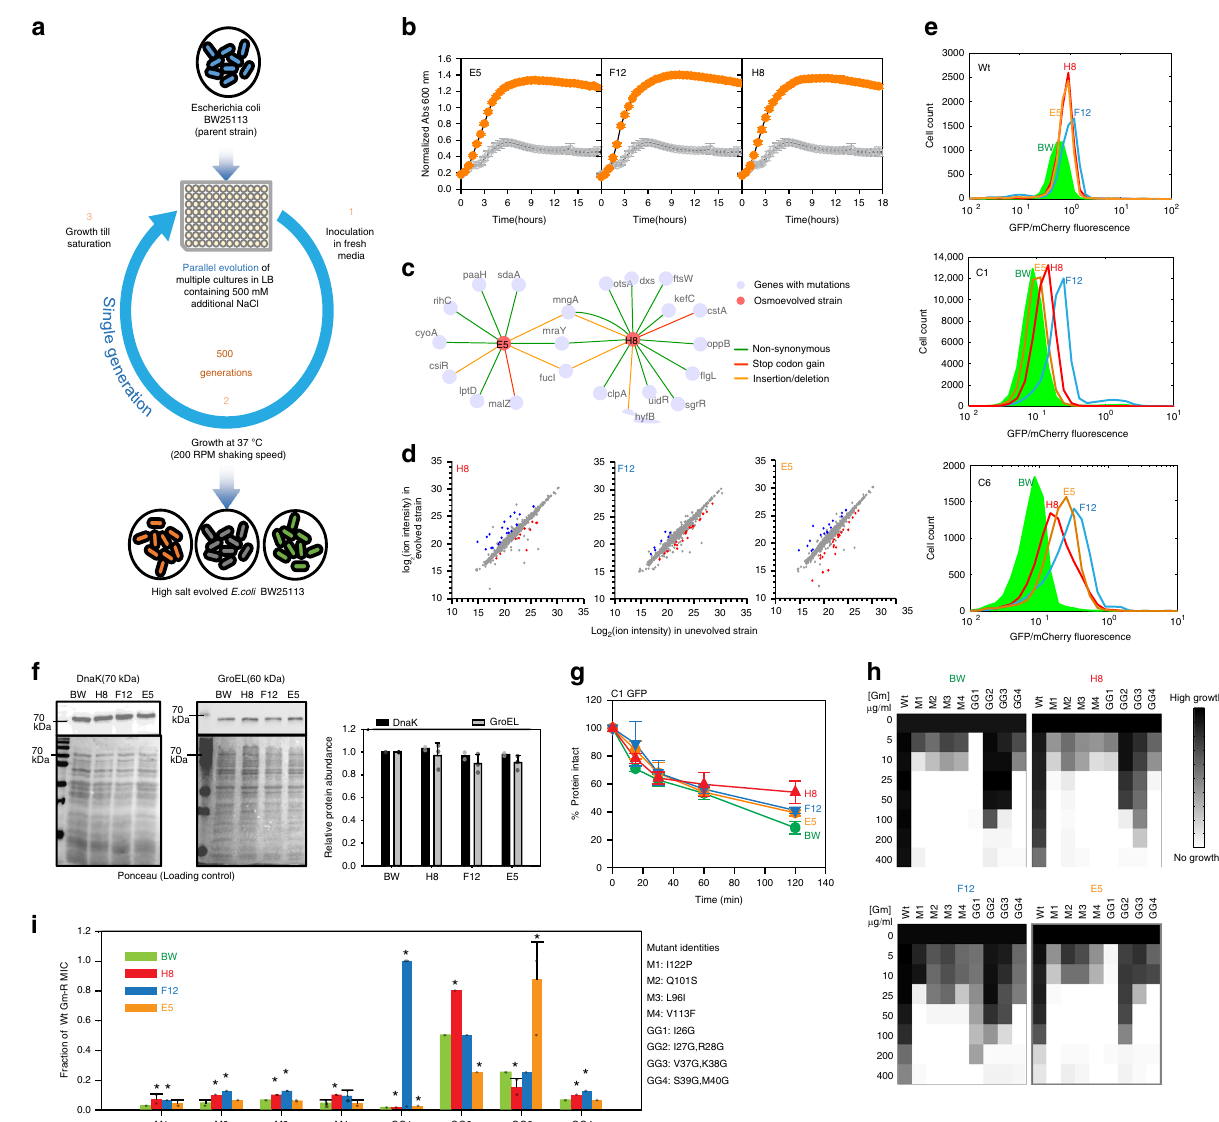
Fig. 8 Wild-type cells evolve altered buffering capacity with evolution of a different metabolome. a Schematic of strategy for Laboratory Adaptive Evolution of osmotolerant strains of E. coli starting from BW (wild-type E. coli K-12, BW25113). b Growth curve of unevolved BW and evolved osmotolerant strains E5, F12, and H8 in 500 mM of NaCl added in excess to LB medium while growing at 37 °C, 200 rpm. c Genetic interaction network map of evolved strains E5 and H8 based on mutations obtained in genome sequencing. d Metabolite features of representative evolved osmotolerant strains (E5, F12, and H8) and its comparison with BW. The colored circled represent metabolites that are signi fi cantly altered in the evolved strains. e Histogram for GFP/ mCherry fl uorescence of Wt, C1, and C6 GFP in the BW and evolved strains (E5, F12, and H8). f Comparative quanti fi cation of chaperone proteins DnaK and GroEL in BW and evolved strains (E5, F12, and H8) done by immunoblotting with speci fi c antibodies. Quanti fi cation of the chaperone levels are shown as bar graphs representing mean values (2-sided Student ’ s t -test p -value > 0.05). g . Chloramphenicol based chase for checking protein degradation rates were performed in BW and evolved strains (E5, F12, and H8) as discussed earlier. Mean of C1 GFP levels at different time points are shown in different strains. h Heatmap for growth-based activity of Gm-R mutants and Wt Gm-R in unevolved strain (BW) and evolved strains (E5, F12, and H8) in increasing concentrations of gentamicin. i Bar graph representing percentage MIC of a selected set of Gm-R mutants w.r.t Wt Gm-R in the respective strains. Mean of four biological replicates is plotted with standard deviation as error bars (unpaired 2-sided Student ’ s t -test * p- value for M1(H8:0.04, F12:0); M2(H8:0.002, F12:0.0002); M3(H8, F12:0); M4(H8:0.002); GG1(F8, F12, E5:0); GG2(H8, E5:0); GG3(H8:0.01, E5:0.002); GG4(H8, F12:0). For b , f , and g : Standard deviations are plotted as error bars from 3 biological replicates. Also see Supplementary Fig. 6 (Source data are provided as source data fi le Fig.